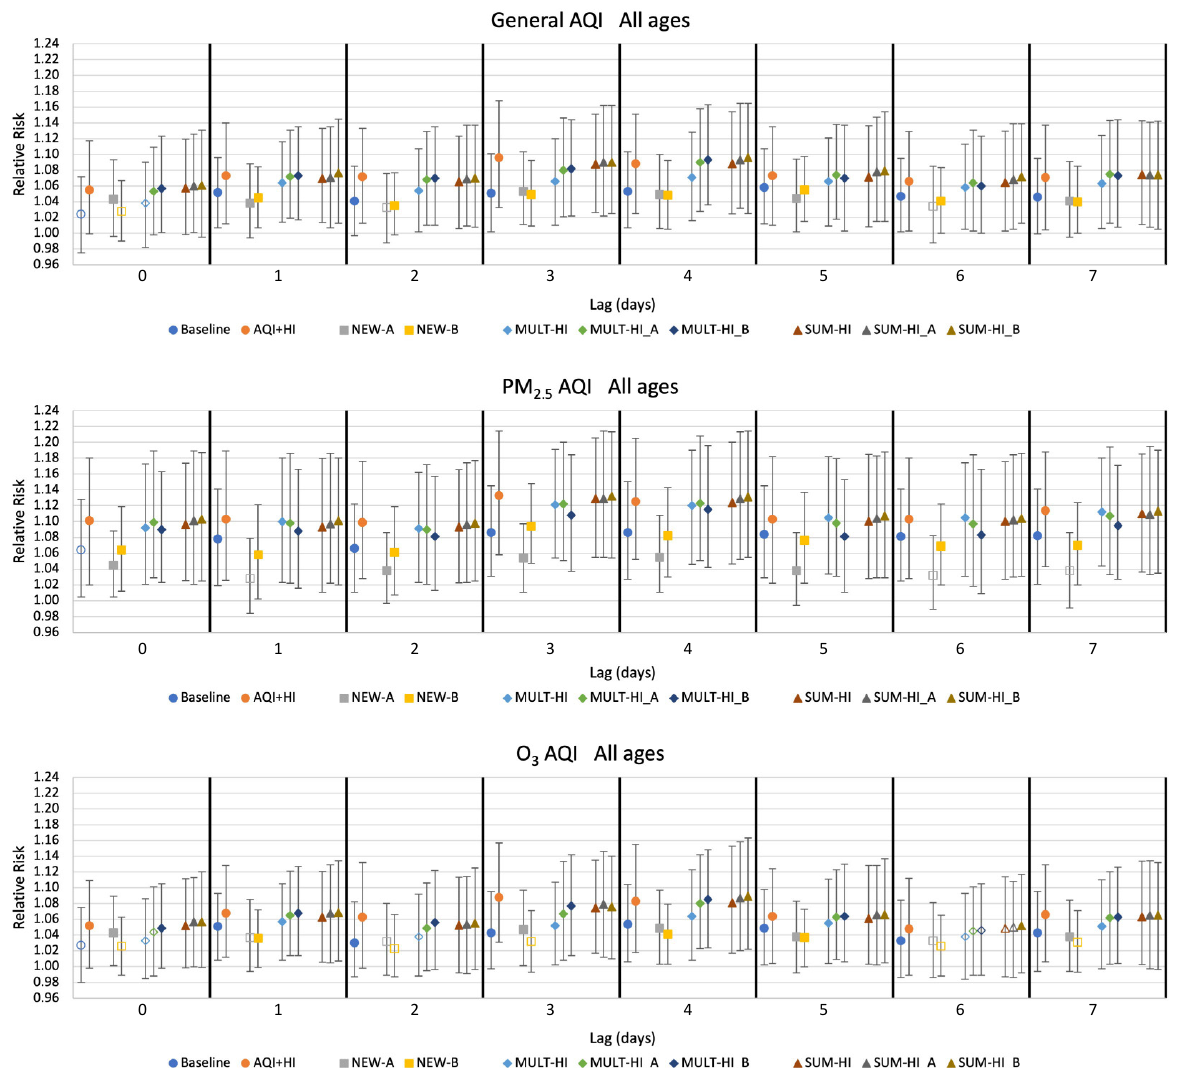
Figure 3. The interquartile relative risks and 95% confidence intervals for all models (deaths of persons of all ages). Model characteristics are described in Table 1. Solid symbols indicate significance at p = 0.05.